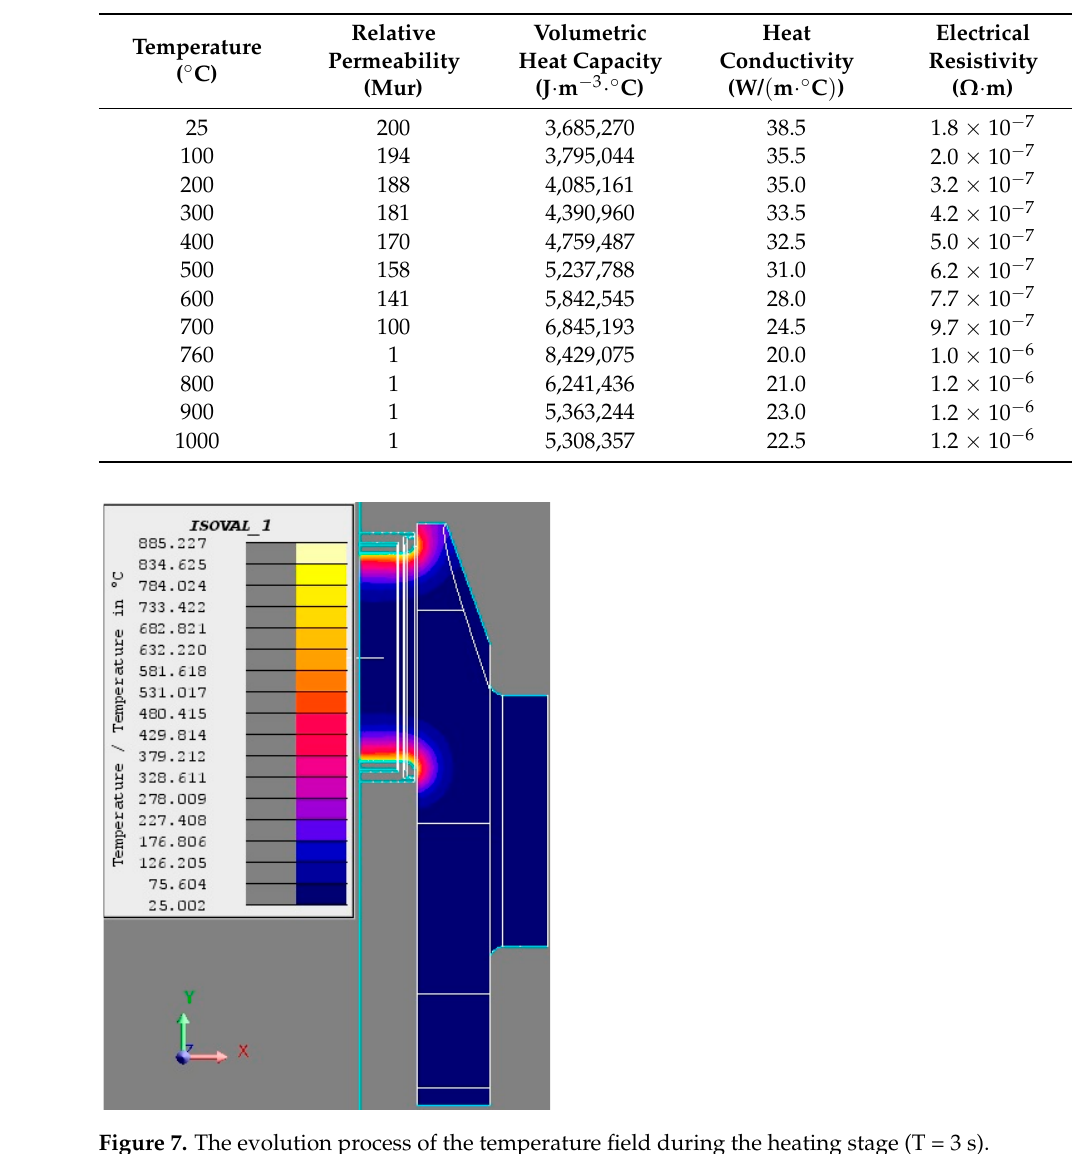
Table 2. Material properties of the crankshaft.